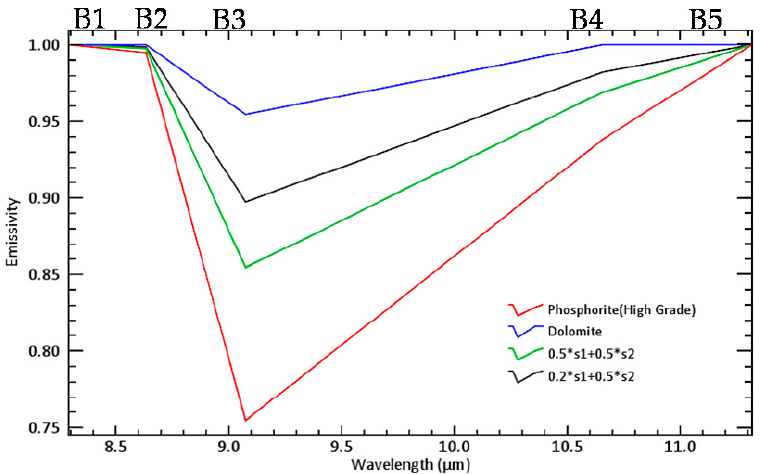
Figure 8. Comparison between phosphorite, dolomite and their intermediate mixed variants. Intermediate mixed variants are derived by linear mixing Emissivity spectra of dolomite (S1) and phosphorite (S2) to understand the role of intrapixel mixing in the detection of phosphorite. Wavelength positions of five TIR bands of ASTER are also shown (B1 to